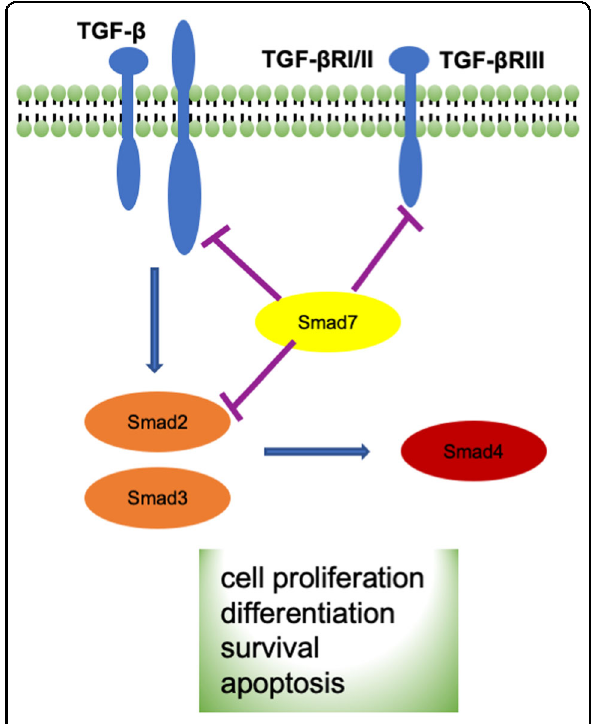
Fig. 1 Canonical TGF- β signaling pathway. Canonical transforming growth factor beta (TGF- β ) signaling is a process that involves ligands (TGF- β 1, TGF- β 2, TGF- β 3), receptors (TGFBRI/II/III), receptor-activated SMADs (R-Smads: Smad2/3; I-Smads: Smad7), and the common Smad (co-Smad: Smad4). TGF- β superfamily ligands bind to a type II receptor, which recruits and phosphorylates a type I receptor. The type I receptor then phosphorylates R-Smads that can bind Smad4. R- Smads/co-Smad complexes accumulate in the nucleus where they act as transcription factors and participate in the regulation of target gene